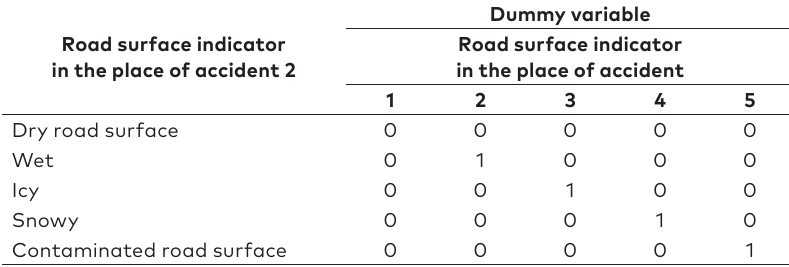
Table 3. Introduction of dummy